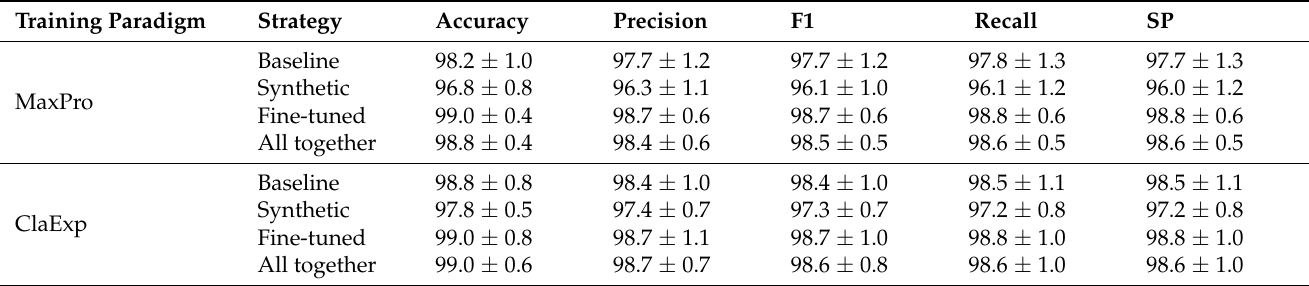
Table 6. Figures of merit for all design strategies measured from the window-based cross-validation method. Synthetic data generated with the expert